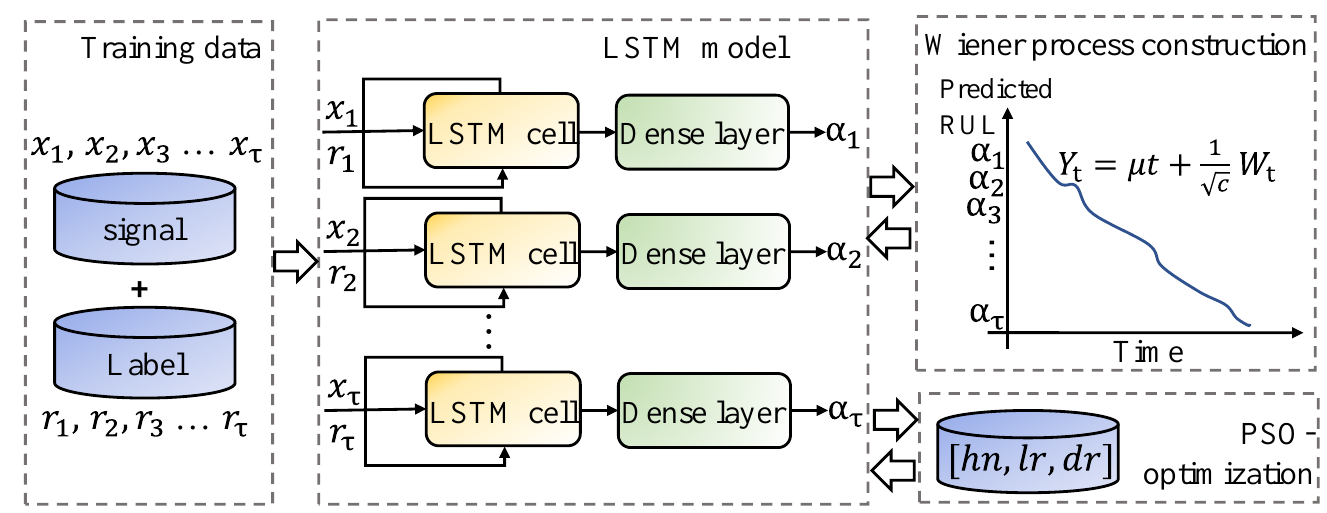
Figure 4. The structure of the Wiener–LSTM model with PSO optimization. The signals measured by sensors are x 1 , x 2 , x 3 ,... x t at time 1,2,3,... t . The corresponding RUL is recorded as r 1 , r 2 , r 3 ,... r t